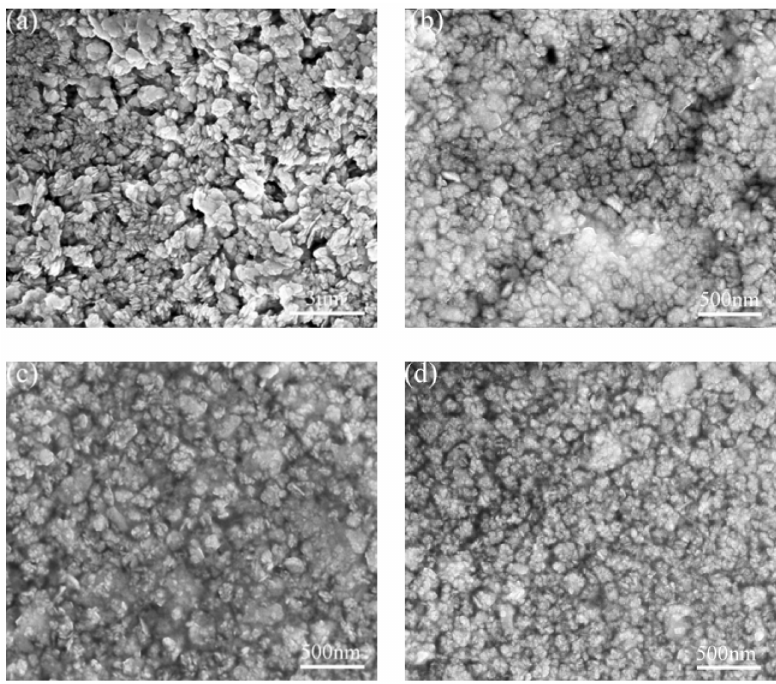
Figure 6. The SEM images of ball-milled tungsten at different milling time with different additive amounts of PCA: ( a ) 6% PCA, 30 h; ( b ) 6% PCA, 60 h; ( c ) 12% PCA, 30 h; ( d ) 12% PCA, 60